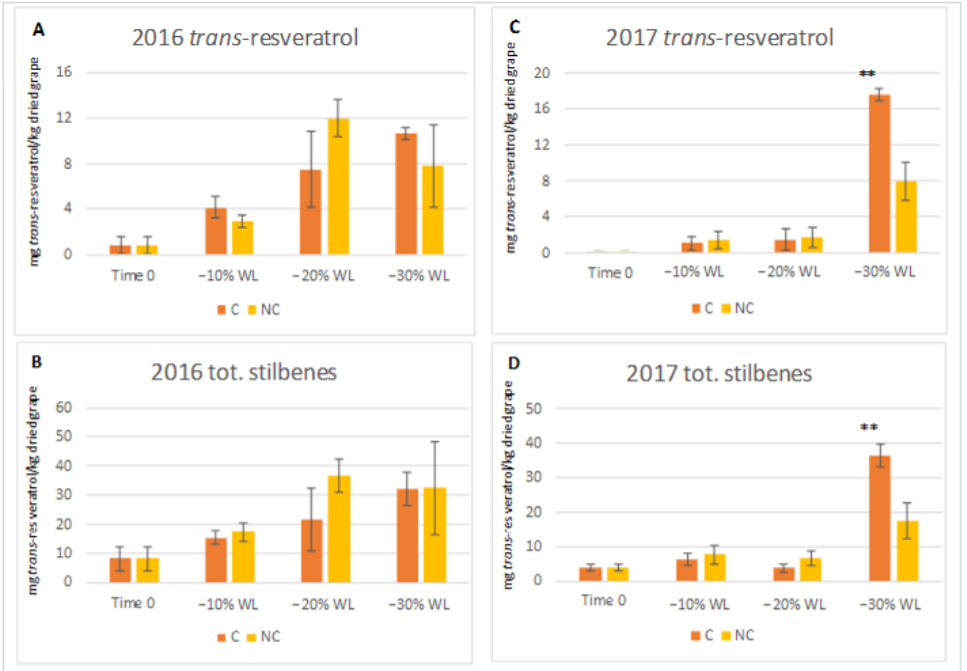
Figure 9. Levels of trans -resveratrol and total stilbenes (( A , B ) for 2016, ( C , D ) for 2017 vintages) calculated as mg trans -resveratrol/kg dried grape (d.g.) during two withering processes carried out in the two years. C, dehydration in RH and WS controlled warehouse; NC, dehydration carried out in the not-controlled environment. ** indicate a significant difference p ≤ 0.01 between the two processes. Vertical bars show the standard deviation of 3 analytical replicates.